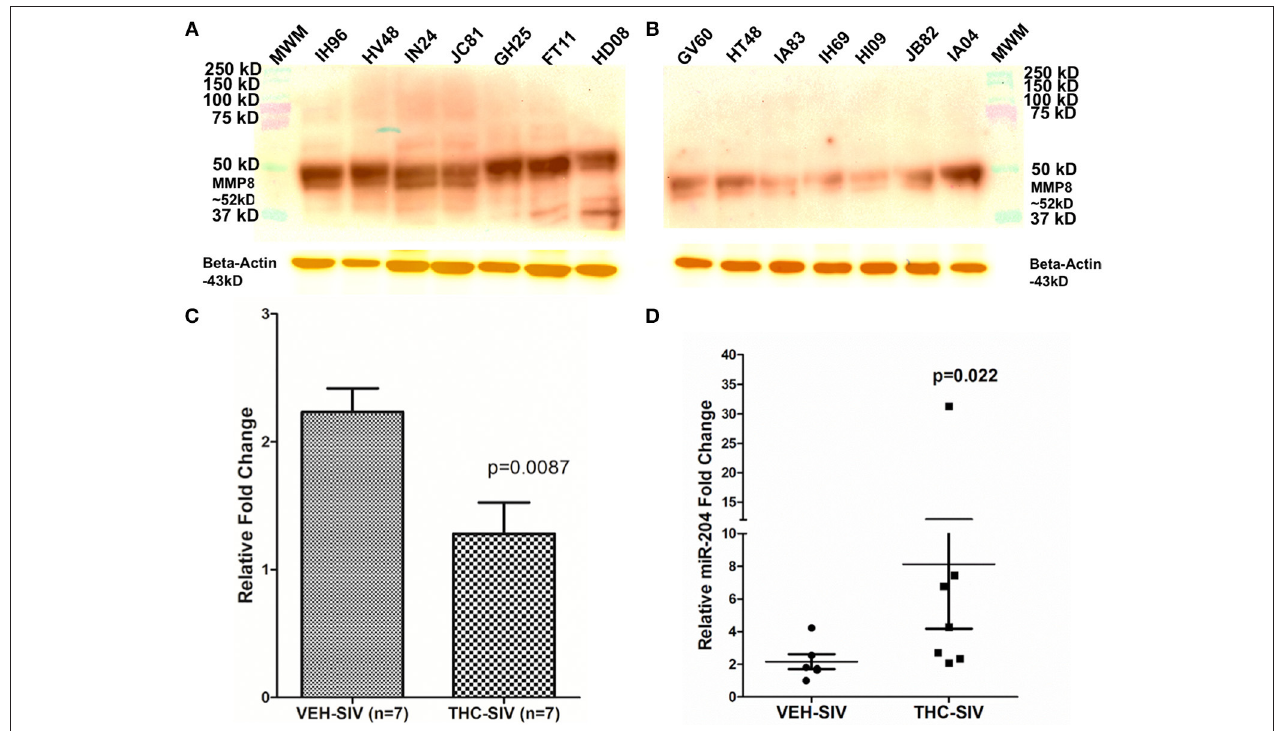
FIGURE 3 | MMP8 protein expression is significantly reduced in whole colon tissue of THC/SIV rhesus macaques. Representative western blot (A,B) and quantification (C) showing a reduction in protein expression of MMP8 ( ∼ 52 kD) in whole colon tissue of THC/SIV rhesus macaques. Immunoprecipitation/Western blotting was performed twice with the same samples. RT-qPCR confirmed significant upregulation of miR-204, a miRNA computationally predicted to directly target MMP8, in colonic epithelium of THC/SIV rhesus macaques (D) . The RT-qPCR analysis was performed twice with the same samples. Immunoprecipitation/western blot densitometry data (C) was analyzed using Mann-Whitney U -test. RT-qPCR data were analyzed using the non-parametric Wilcoxon’s rank sum test for independent samples. The error bars represent standard error of mean fold change within each group. MWM- Molecular weight marker.